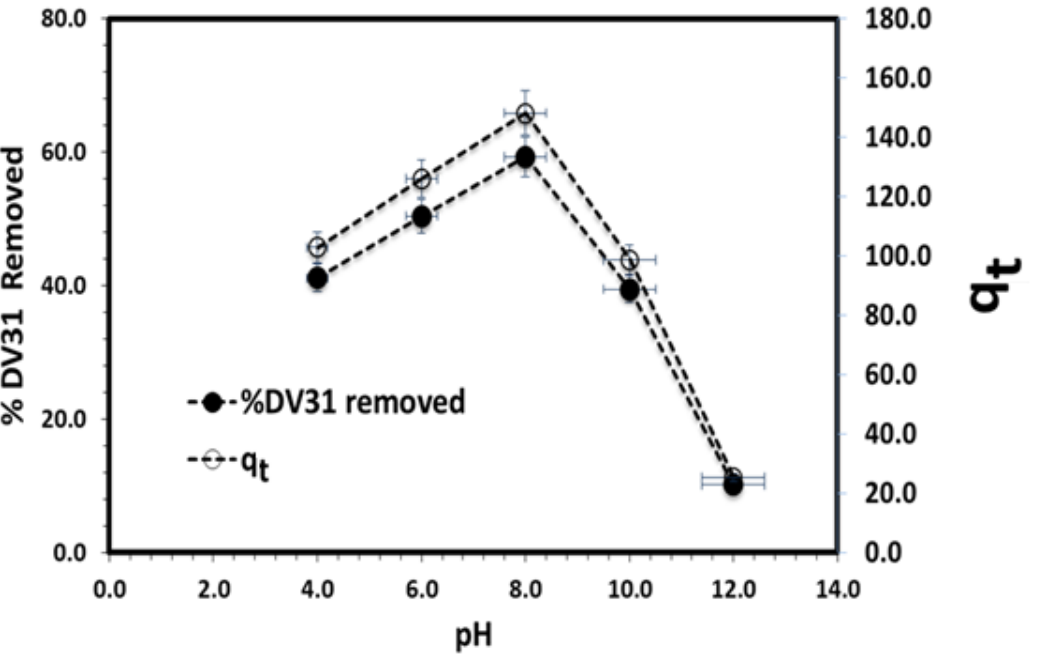
Figure 11. Effect of solution pH on DV31 dye removal from an aqueous solution by CuO NPs. (Ex ‐ perimental conditions: DV31 concentration 25 mg/L; 0.5 mL H 2 O 2 ; sample volume 100 mL; 10.0 mg CuO NPs; 30 min contact time and temperature at 25 °C).